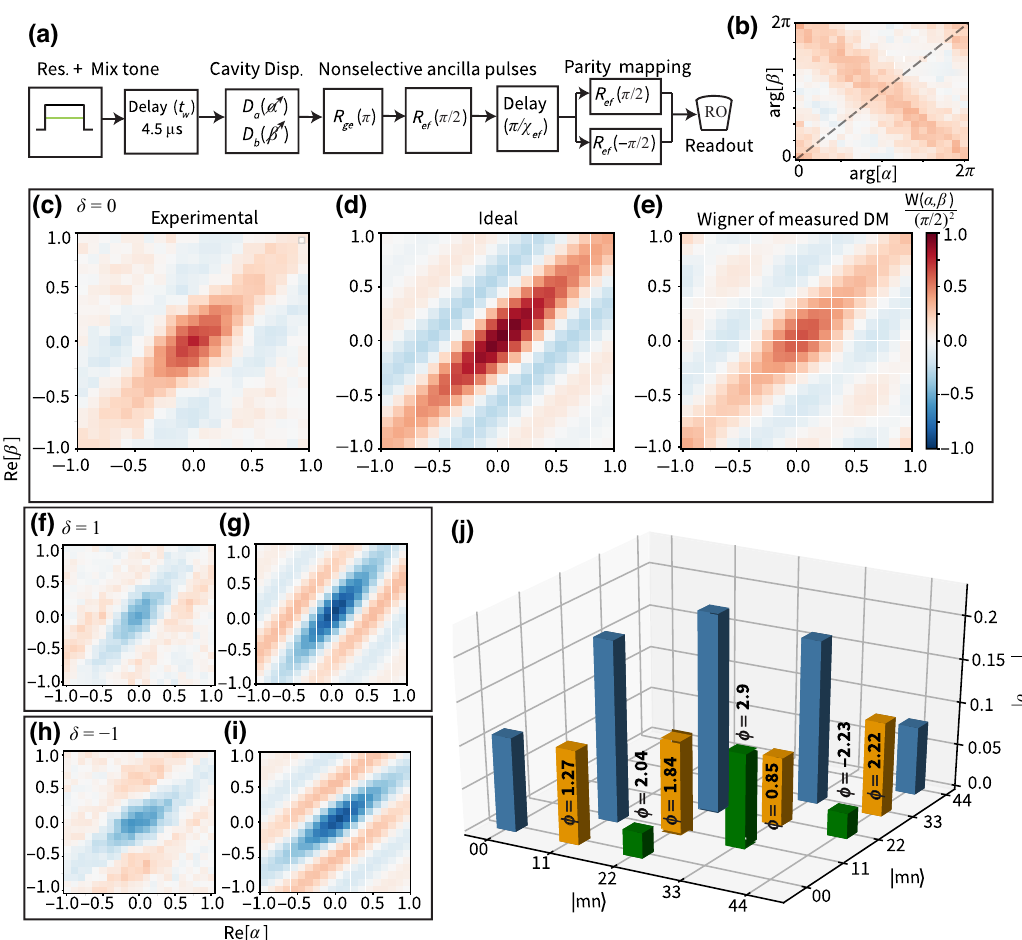
FIG. 4. The joint Wigner tomography of PCSs. (a) The pulse sequence for Wigner-function measurements. The two cw tones are applied for t = 15 µ s to prepare and stabilize a state that is then evolved under no pump tones for t w = 4.5 µ s to reach the first phase revival of an approximate PCS under cavity Kerr dynamics (and for the reservoir to relax to vacuum). The joint parity mapping uses a Ramsey sequence with an evolution time of π/χ ef , where χ ef ≈ χ f a − χ a ≈ χ f π 2 W (α , β) , of the stabilized δ = 0 state with constant displacement amplitudes | α | = | β | = 0.3 and sweeping over the angle of both 4 displacements. (c) The measured Re[ α ]-Re[ β ] cut of the joint Wigner function for the approximate | γ = 2.3, δ = 0 (cid:2) PCS (with the real axes redefined such that arg[ γ ] = 0). This can be compared to the same Wigner-function cuts of (d) the ideal PCS | 2.3, 0 (cid:2) and (e) the experimentally measured density-matrix block [as shown in (j)] of this stabilized state. (f),(h) The measured Re[ α ]-Re[ β ] cut of the joint Wigner function for the approximate | γ = 2.4, δ = 1 (cid:2) and | γ = 2.2, δ = − 1 (cid:2) PCSs stabilized under the same condition, to be compared to (g),(i) the corresponding ideal PCSs, respectively. (j) The δ = 0 block of the density matrix of the stabilized δ = 0 state at the same effective free-evolution time, measured with quantum subspace tomography (note that this is independent from the Wigner measurements) as discussed in Sec. IV. The blue bars are the diagonal elements indicating the population distribution, whereas the off-diagonal coherence elements are shown by orange (green) for nearest (next-nearest) neighboring Fock-state pairs. Other coherence elements are small and hence are not measured in the experiment. The phases of the coherence elements are shown numerically over the